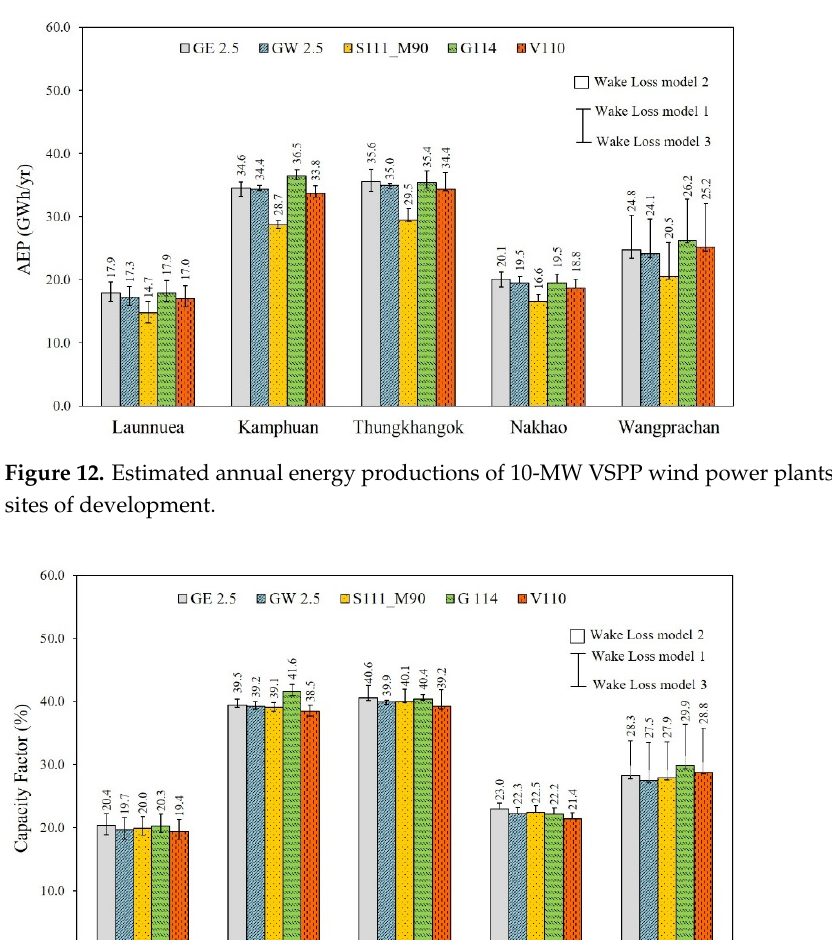
Figure 13. Estimated capacity factors of 10-MW VSPP wind power plants at the potential sites of development.